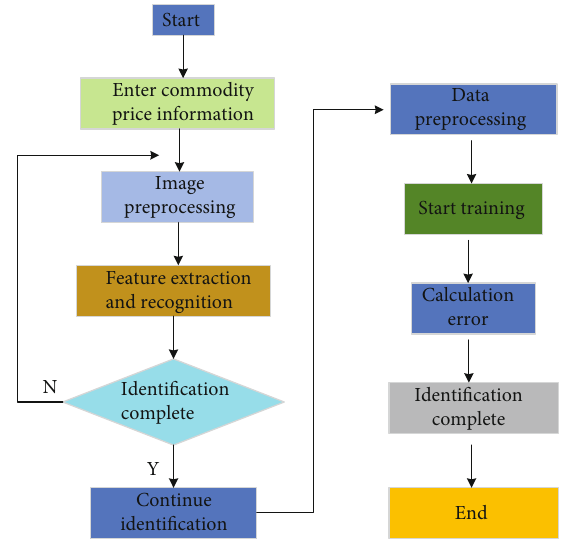
Figure 2: Flow chart of